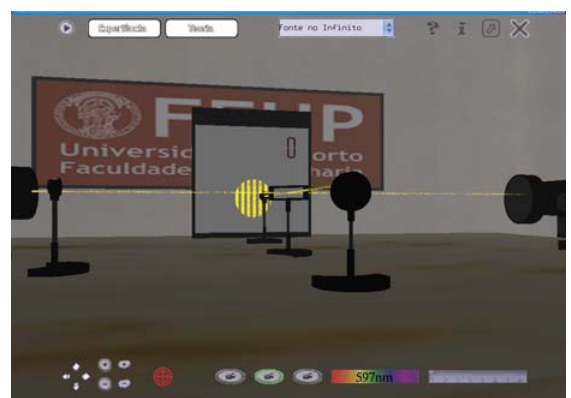
Figure 2. Virtual Michelson